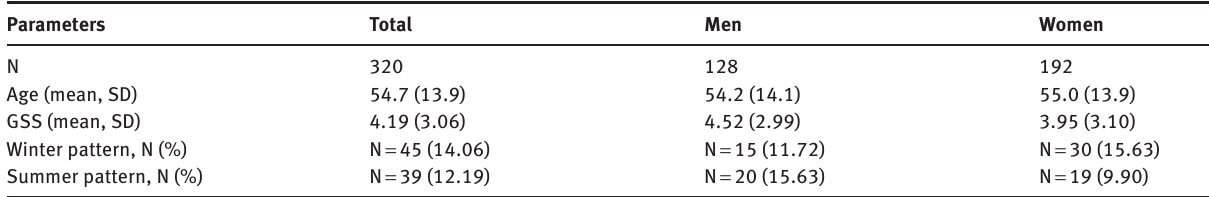
Table 1: Seasonality of mood and behavior, patterns and gender differences. Parameters